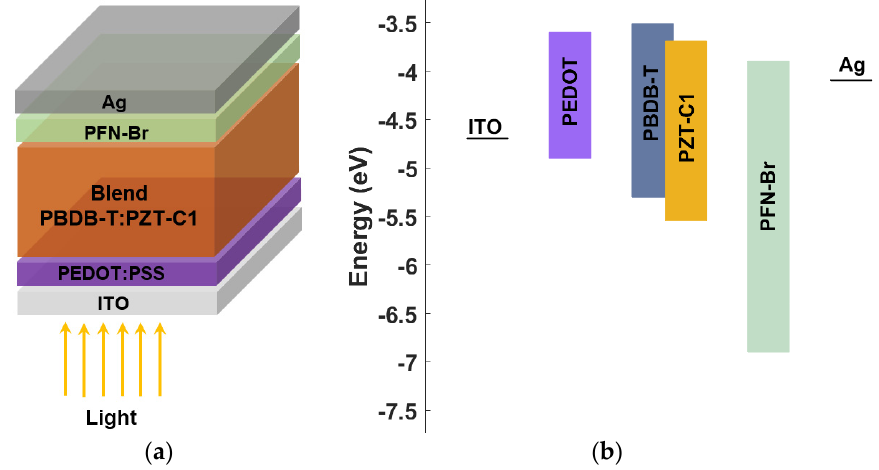
Figure 1. Polymer-based solar cell structure: ( a ) basic layers ITO/PEDOT/PBDB-T:PZT/PFN/Ag, ( b ) energy band profile before contact, showing LUMO and HOMO energy levels in eV. Table 1. Main input parameters of the various layers of the polymer-based solar cell [24,33,42]. Parameters PEDOT:PSS